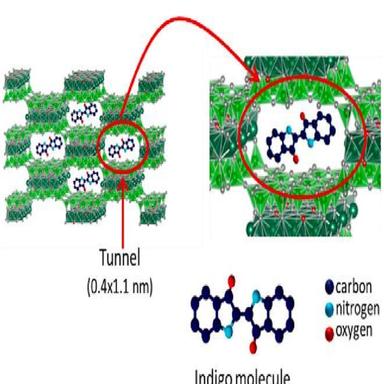
Schematic representation of the sepiolite crystalline structure and the indigo molecule inserted in their tunnels. (For interpretation of the references to colour in this figure legend, the reader is referred to the web version of this article.)